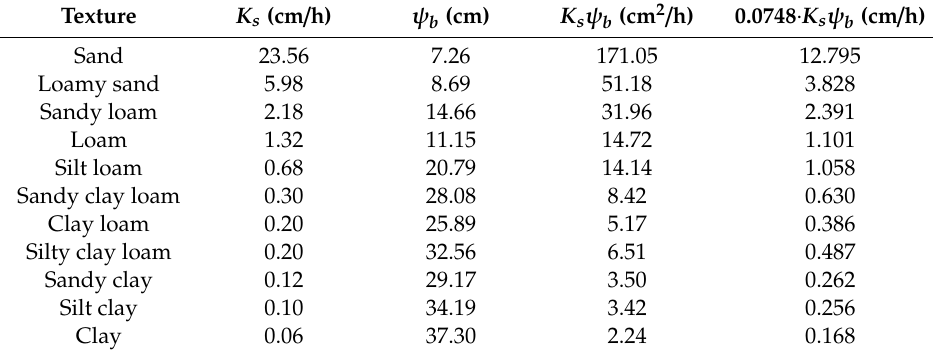
Table 1. Parameters of di ff erent soil